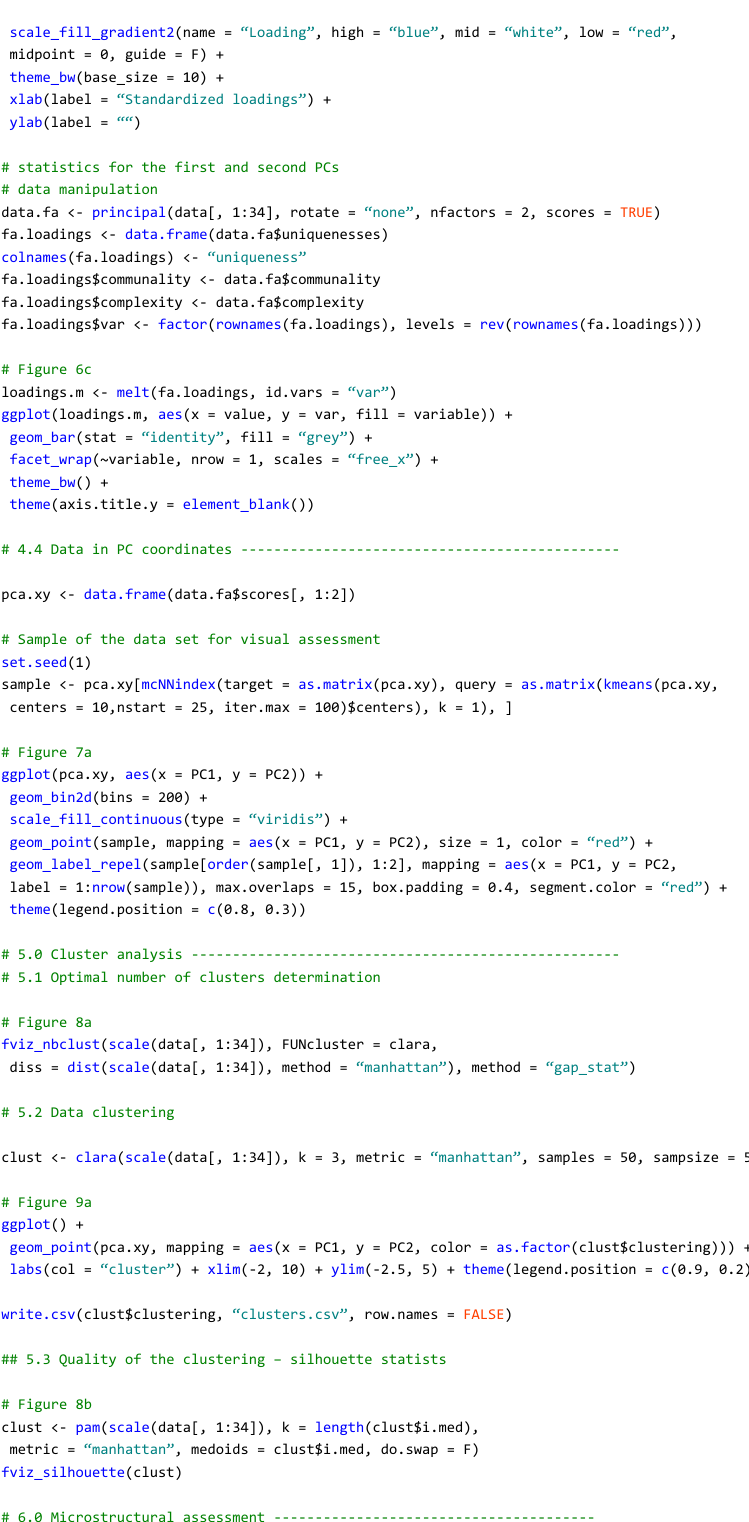
# Figure 8b clust <- pam(scale(data[, 1:34]), k = length(clust$i.med), metric = “manhattan”, medoids = clust$i.med, do.swap = F) fviz_silhouette(clust)